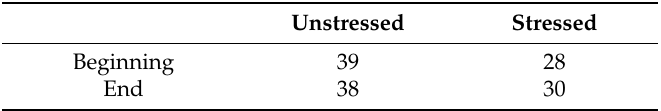
Table A11. Token counts for vowel formant measurements used to visualize vowel space and calculate vowel space area for Informant D in Section 4.2.4.